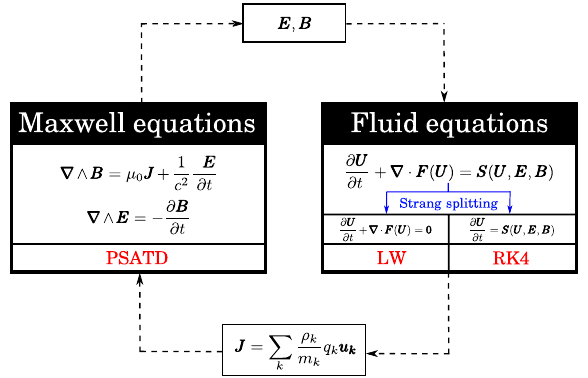
Figure 1. Schematic representation of the solver’s